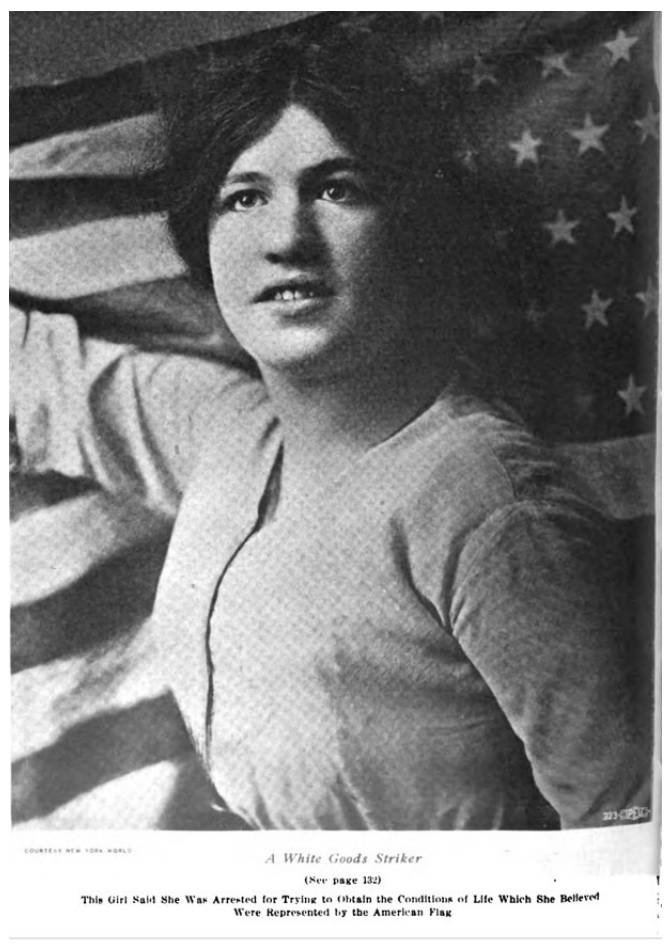
Figure 14. Life and Labor 1913 (February). “A White Goods Worker.” Frontispiece.